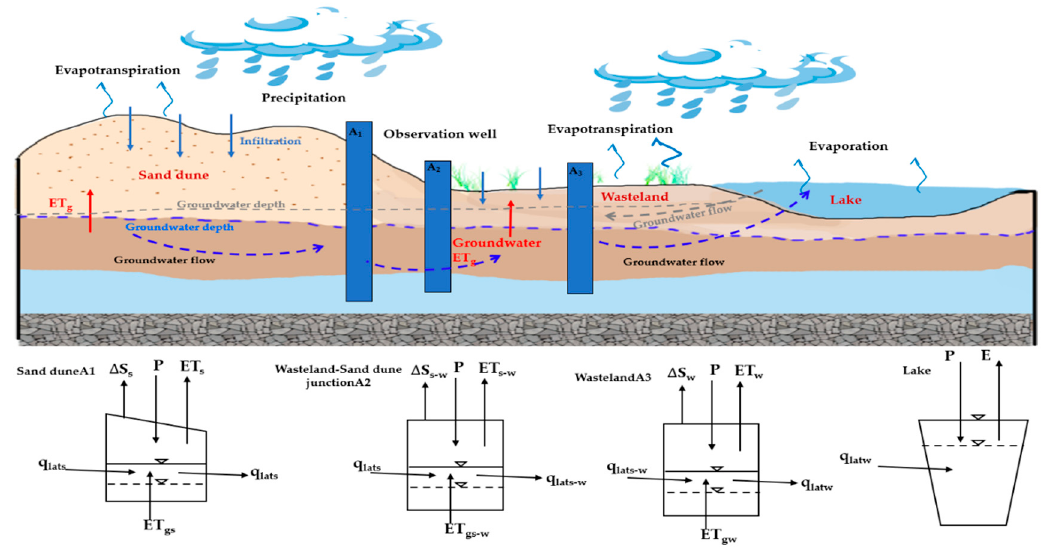
Figure 5. Theoretical-model construction of water and salt transport in sand dune–wasteland–lake system.